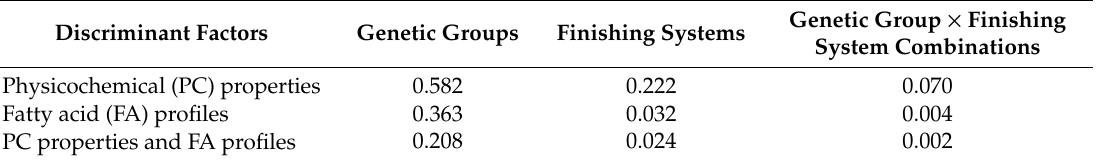
Table 2. Estimated Wilk’s lambda in discriminant analyses of meat samples according to genetic group, finishing system or genetic group × finishing system combinations based on meat physicochemical properties, fatty acid profiles or